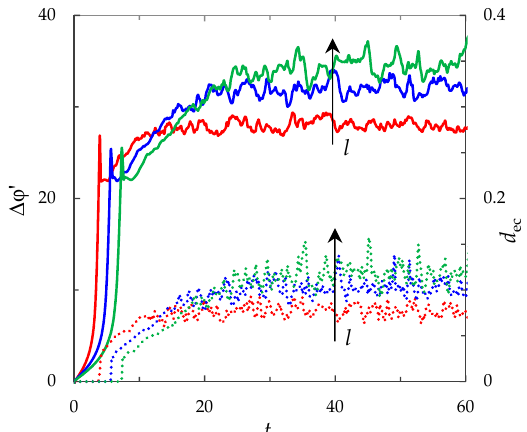
Figure 11. ChP (solid lines) and average thickness of the electroconvective mixing layer, d ec (dotted lines). The results of calculation for l = 4 (red lines), 8 (blue lines), 12 (green lines) at current density i av / i lim = 2.